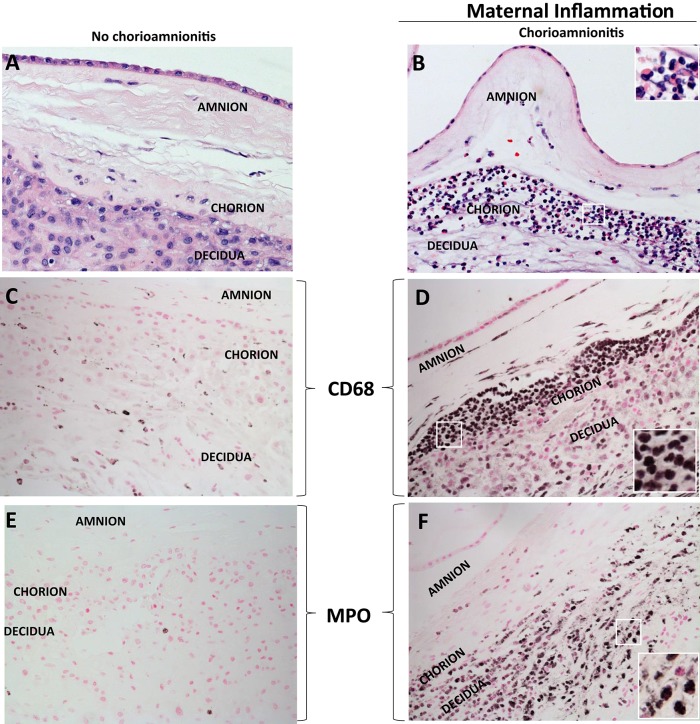
H&E histology of intrauterine inflammations. (A,B) Cross sections of human fetal membranes H&E histology showing neutrophil infiltration. Chorioamnionitis is characterized by infiltration of (D) CD68+ macrophages and (F) neutrophils expressing Myeloperoxidase+ (MPO) predominantly located at the choriodecidua junction. Note relatively much fewer CD68 or MPO expressing cells in the no chorioamnionitis group (C,E). Insets in (B,D,F) show higher power magnification of demarcated area in white and demonstrate inflammatory cells including neutrophils and macrophages.